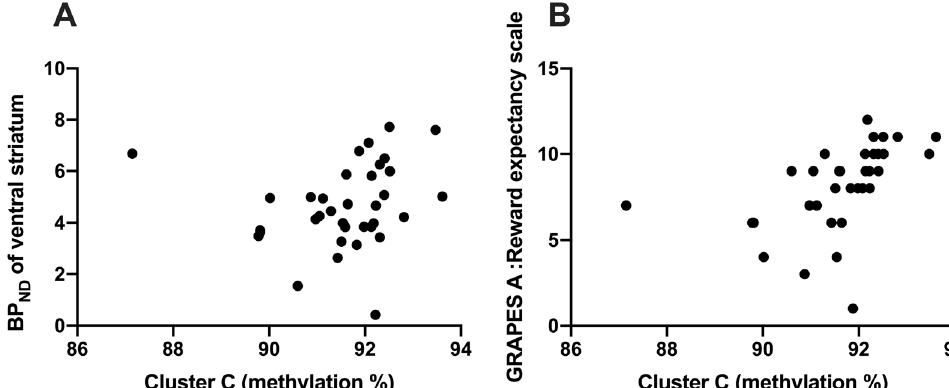
Fig. 3 Correlation of mean percentage of methylation (%) from cluster C with a DAT availability and b